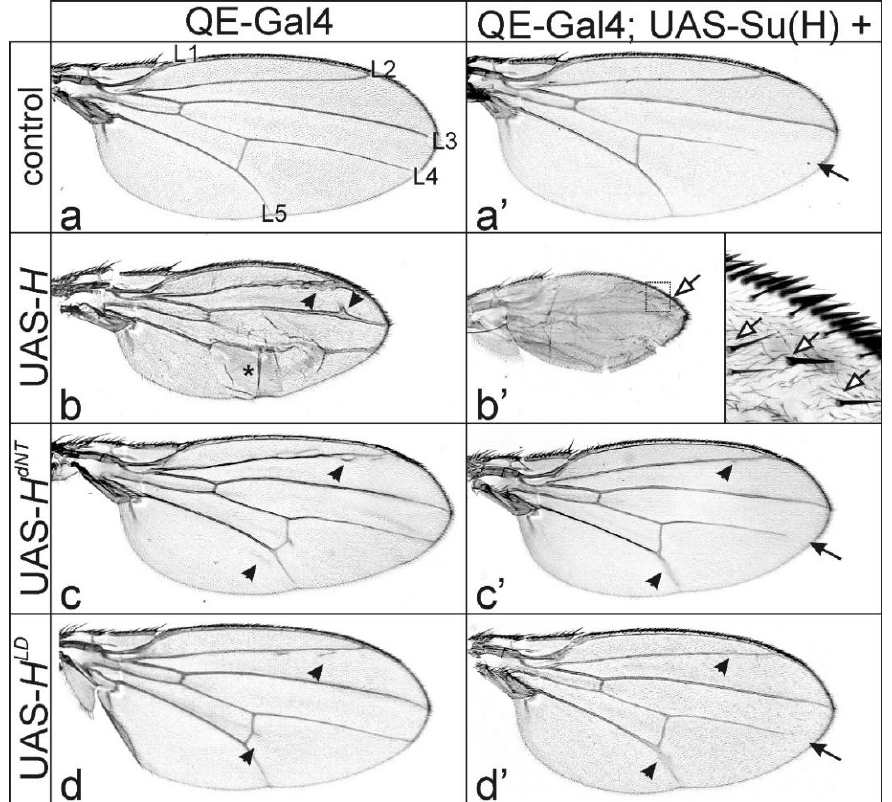
Figure 3. Overexpression of H protein variants in the presumptive wing tissue using QE-Gal4. ( a – d’ ) UAS- H* transgenes, as indicated, were overexpressed in the presumptive wing tissue using QE-Gal4 at 18 °C. ( a ) UAS-GFP served as control; longitudinal veins are numbered. ( b ) Overexpression of wild type H protein affected wing size and tissue adhesion (asterisk). The most prominent phenotype, however, was a thickening of veins and formation of ectopic veinlets (arrowheads point to examples). ( c , d ) The latter was also observed upon the overexpression of H dNT (c) or H LD (d) variants compromised in Su(H) binding (arrowheads point to examples). ( a’ – d’ ) UAS- Su(H) plus the respective UAS- H* transgenes were overexpressed in combination in the developing wing field with QE-Gal4. ( a’ ) Su(H) overexpression alone caused a loss of distal parts of longitudinal veins (arrow). ( b’ ) A combined overexpression of UAS- Su(H) with UAS- H resulted in a transformation of intervein to vein tissue, as well as the emergence of ectopic bristle organs (open arrow, see enlargement). Combination of Su(H) with either H dNT ( c’ ) or H LD ( d’ ), however, gave a mixed phenotype with erased distal wing veins (arrow) plus ectopic veinlets (arrowheads), indicating lack of repressor complex formation. Female wings are shown.